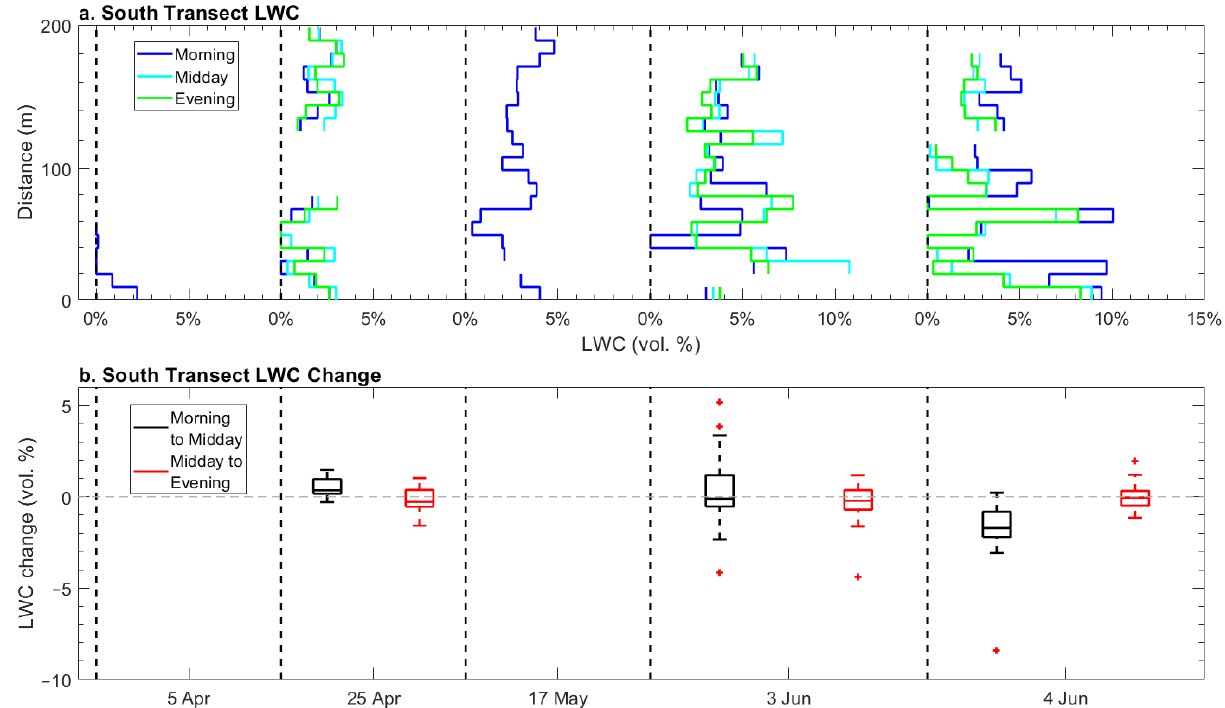
Figure 13. ( a ) South Transect LWC averaged along 9 m intervals for morning, midday, and evening surveys, plotted with distance along transect. Explainable outliers were removed and are represented as breaks in the line. ( b ) Box plots of ∆ LWC along the South Transect from morning to midday and from midday to evening, where positive values represent an increase in LWC, and negative values represent a decrease in LWC.